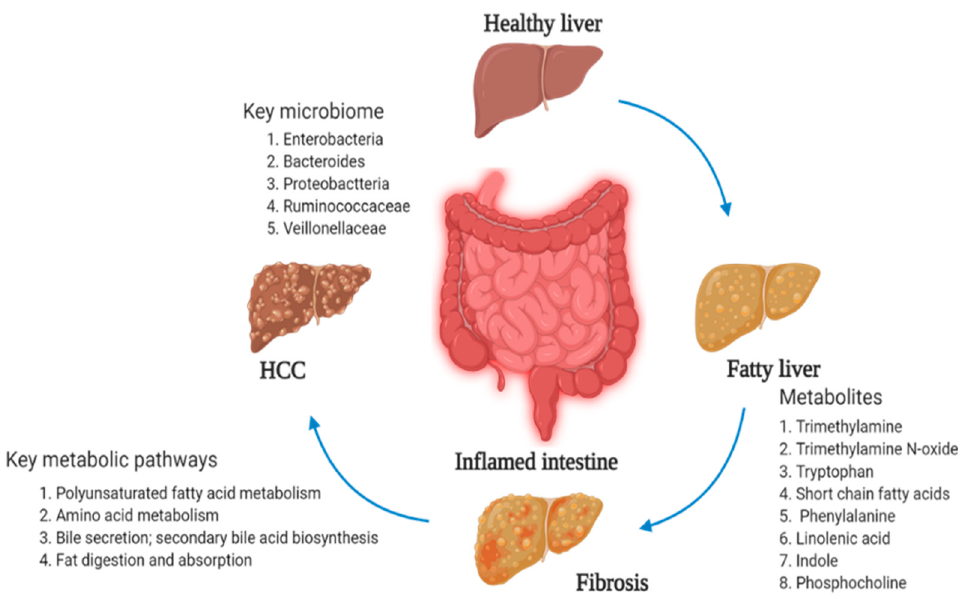
Figure 7. Suggested metabolic effects in gut microbiome and liver